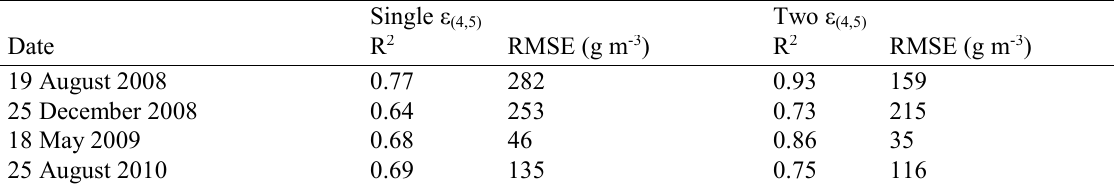
Table 1 Values of R 2 and RMSE obtained using a single mean value of ε ( 4,5) and two value of ε (4,5) . Single ε (4,5) Two ε (4,5) R 2 RMSE (g m -3 ) RMSE (g m -3